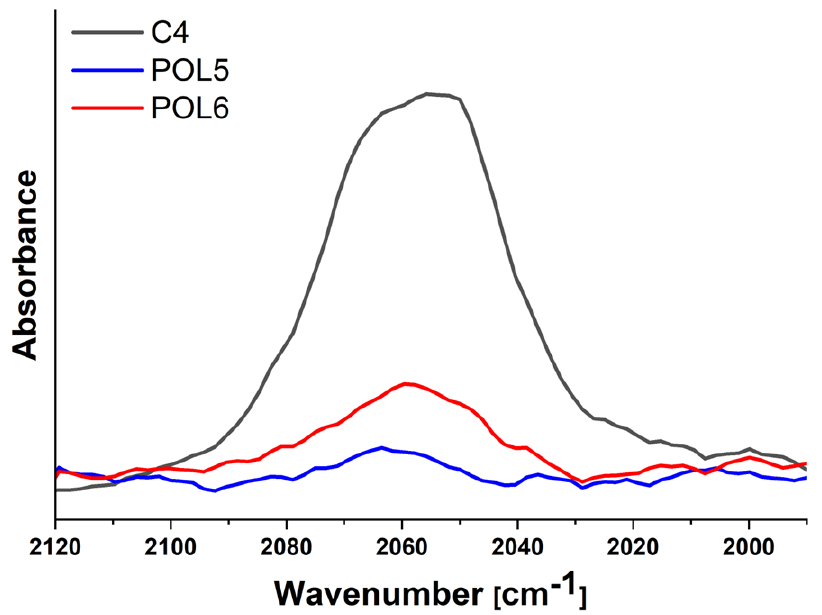
Figure 3. The region of stretching vibrations of the azide groups of cluster C4 and polymer-cluster conjugates POL5 and POL6 in ATR FTIR spectra after subtraction of the corresponding spectrum of water. After conjugation of C4 with the precursor P5 , affording POL5 , and further intro- duction of amine groups along the polymer backbone affording POL6, the asymmetric stretching band intensity of the azide groups greatly decreased (Figure 3, blue and red lines) due to newly formed covalent bond. As the bands’ position remained in the same region, the peak area tool in the OMNIC software was used to compare their intensities in the spectra of POL5 and POL6 using C4 band as a reference. After the conjugation reaction, 9% ± 1% of azide groups remained unreacted for POL5, and similar value was found for POL6 . This assessment indicates that the click reaction was successful as majority of the azide groups